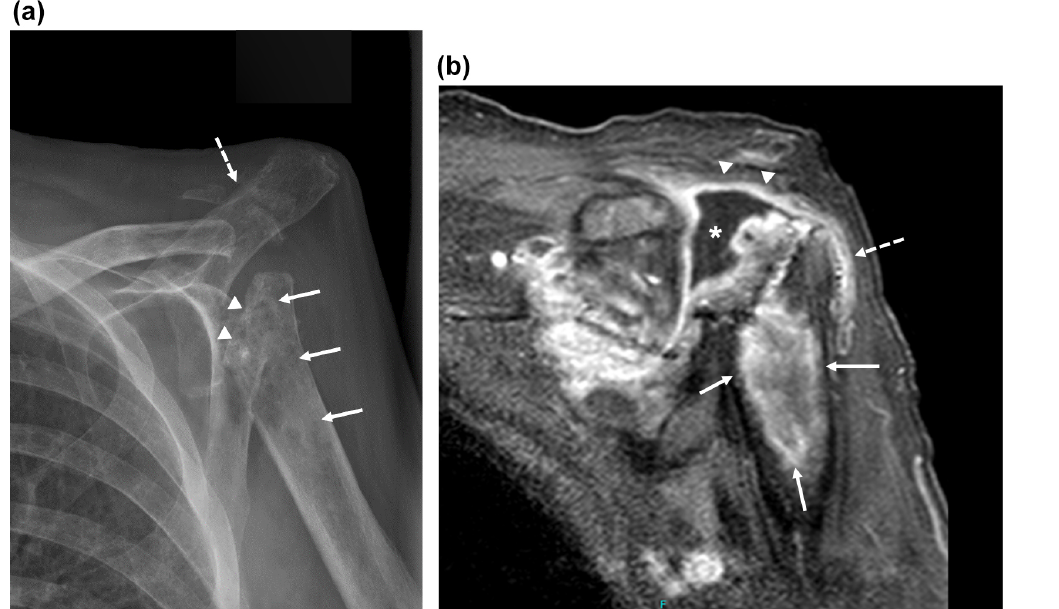
Figure 2. Imaging of the left shoulder 18 months after arthroplasty removal. (a) Anteroposterior radiograph of the left shoulder demon- strating erosion of the left proximal humerus at the site of explanted arthroplasty hardware (arrowheads) with extensive osseous mottling, demineralization, patchy sclerosis, and cortical thinning of the proximal humeral metadiaphysis (white arrows). Osseous fragmentation and erosion at the acromioclavicular joint, with secondary AC joint separation (dashed white arrow). These findings are highly suspicious for septic arthritis with osteomyelitis. (b) Coronal T1-weighted magnetic resonance image of the shoulder with fat saturation demonstrating peripheral gadolinium contrast enhancement (arrowheads) surrounding a moderate glenohumeral joint effusion in the location of the eroded humeral head (*) with extension to the subacromial–subdeltoid bursa (dashed arrow) and in continuity with a large, rim-enhancing proximal humeral metadiaphyseal intra-osseous abscess (white